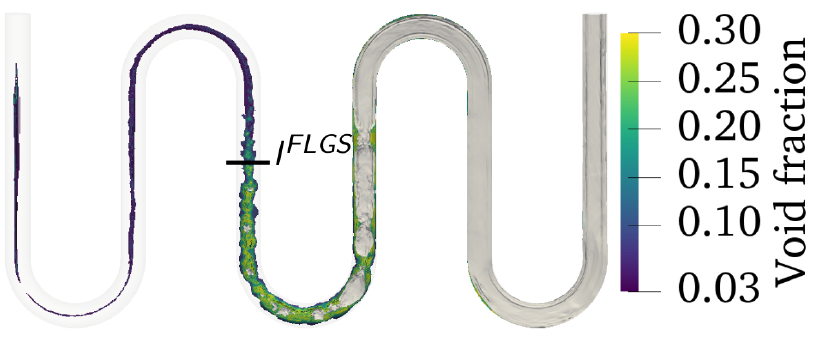
Figure 8. Instantaneous visualization of the vapor content in the calculation domain. Large interfaces were produced by the isocontour α v = 0.5 in gray, and the dispersed bubbles are represented by the color map. The apparition of the First Large Gas Structure is